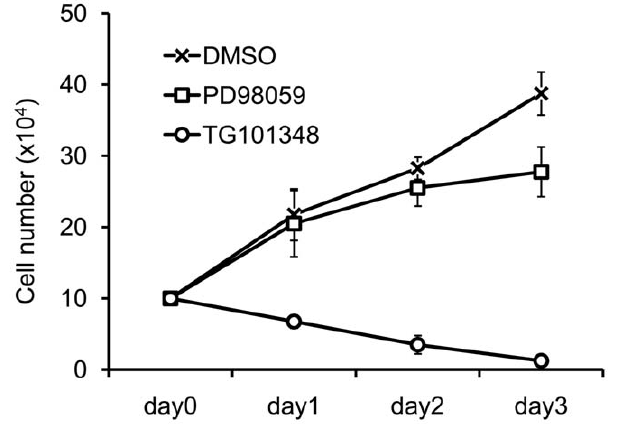
growth of M-MOK cells. M-MOK cells were pre-treated with either 25 m M of Jak2 inhibitor (TG101348), MAPK inhibitor (PD98059) or solvent DMSO for 1 hour before TPO addition. Cell proliferation was determined by counting viable cell numbers for 3 consecutive days. (Data represent mean 6 SD and results are representative of three independent experiments).